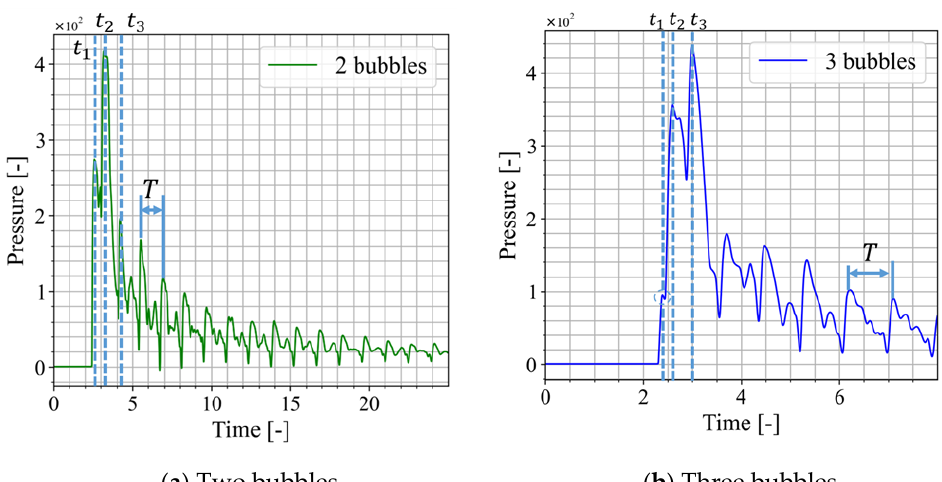
Figure 11. Pressure-time history measured at the pressure probe.